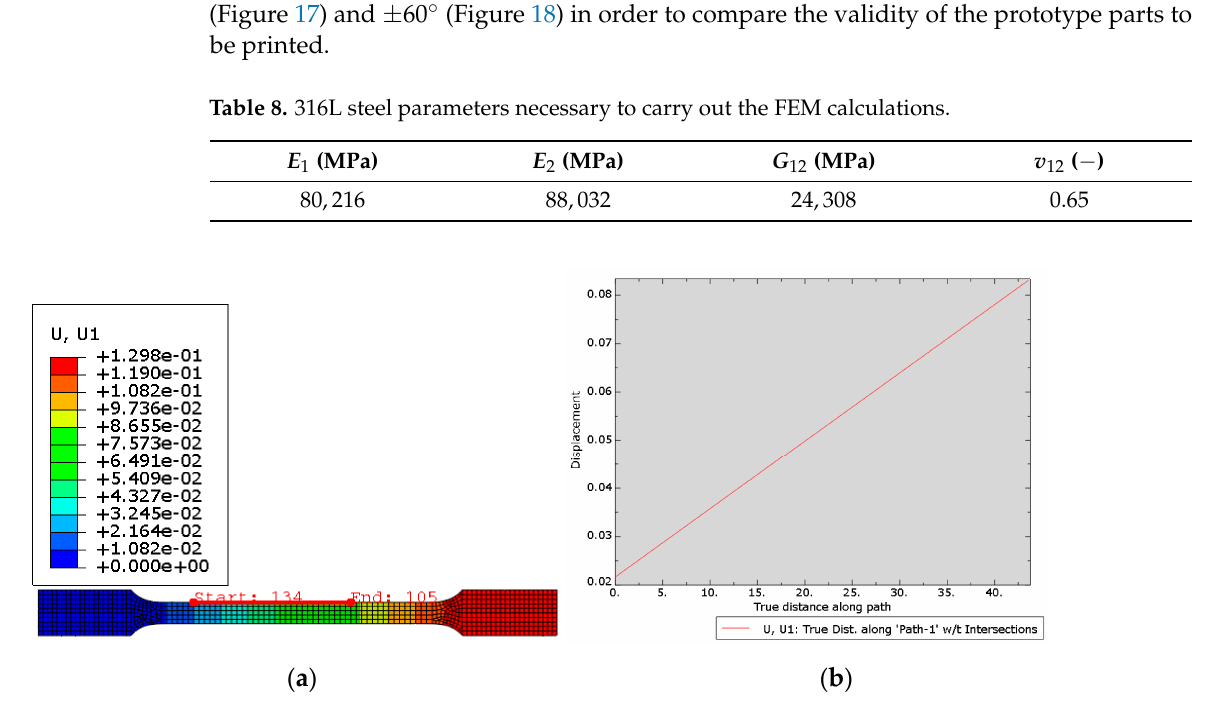
Figure 17. ( a ) Displacement map; ( b ) Plot from the path for sample with lamination angle ± 30 ◦ .